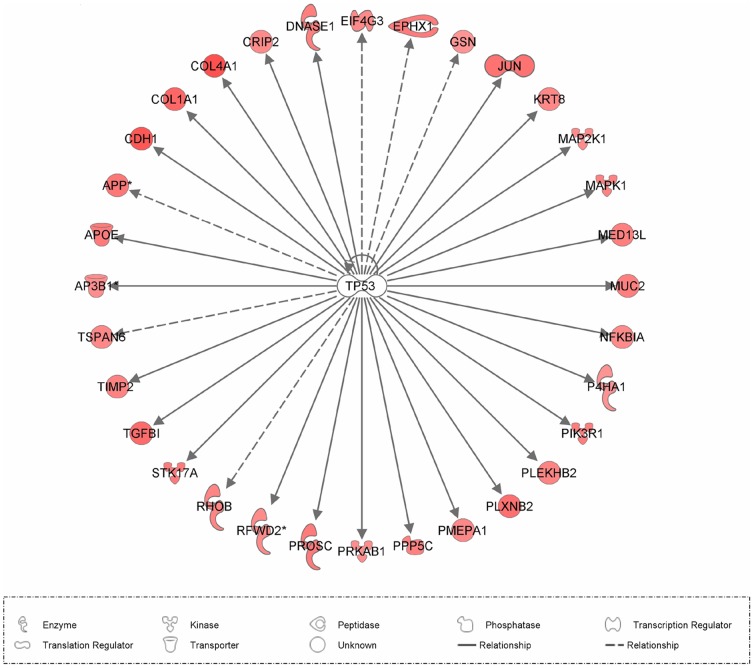
Canonical pathways enriched for transcripts showing different abundance depending on receptivity group and day of estrous cycle.Pathways showing temporal regulation from day 3 to day 7 are given at the horizontal vectors of either the HR (top part) or the LR group (lower part) (↑ = higher transcript abundance at day 3, ↓ = lower transcript abundance at day 3). Pathways of transcript showing different abundance among the Hr and LR at day 3 (left) or day 7 od estrous cycle are displayed at the vertical vectors (↑ = higher transcript abundance in the HR groups, ↓ = lower transcript abundance in the HR groups).